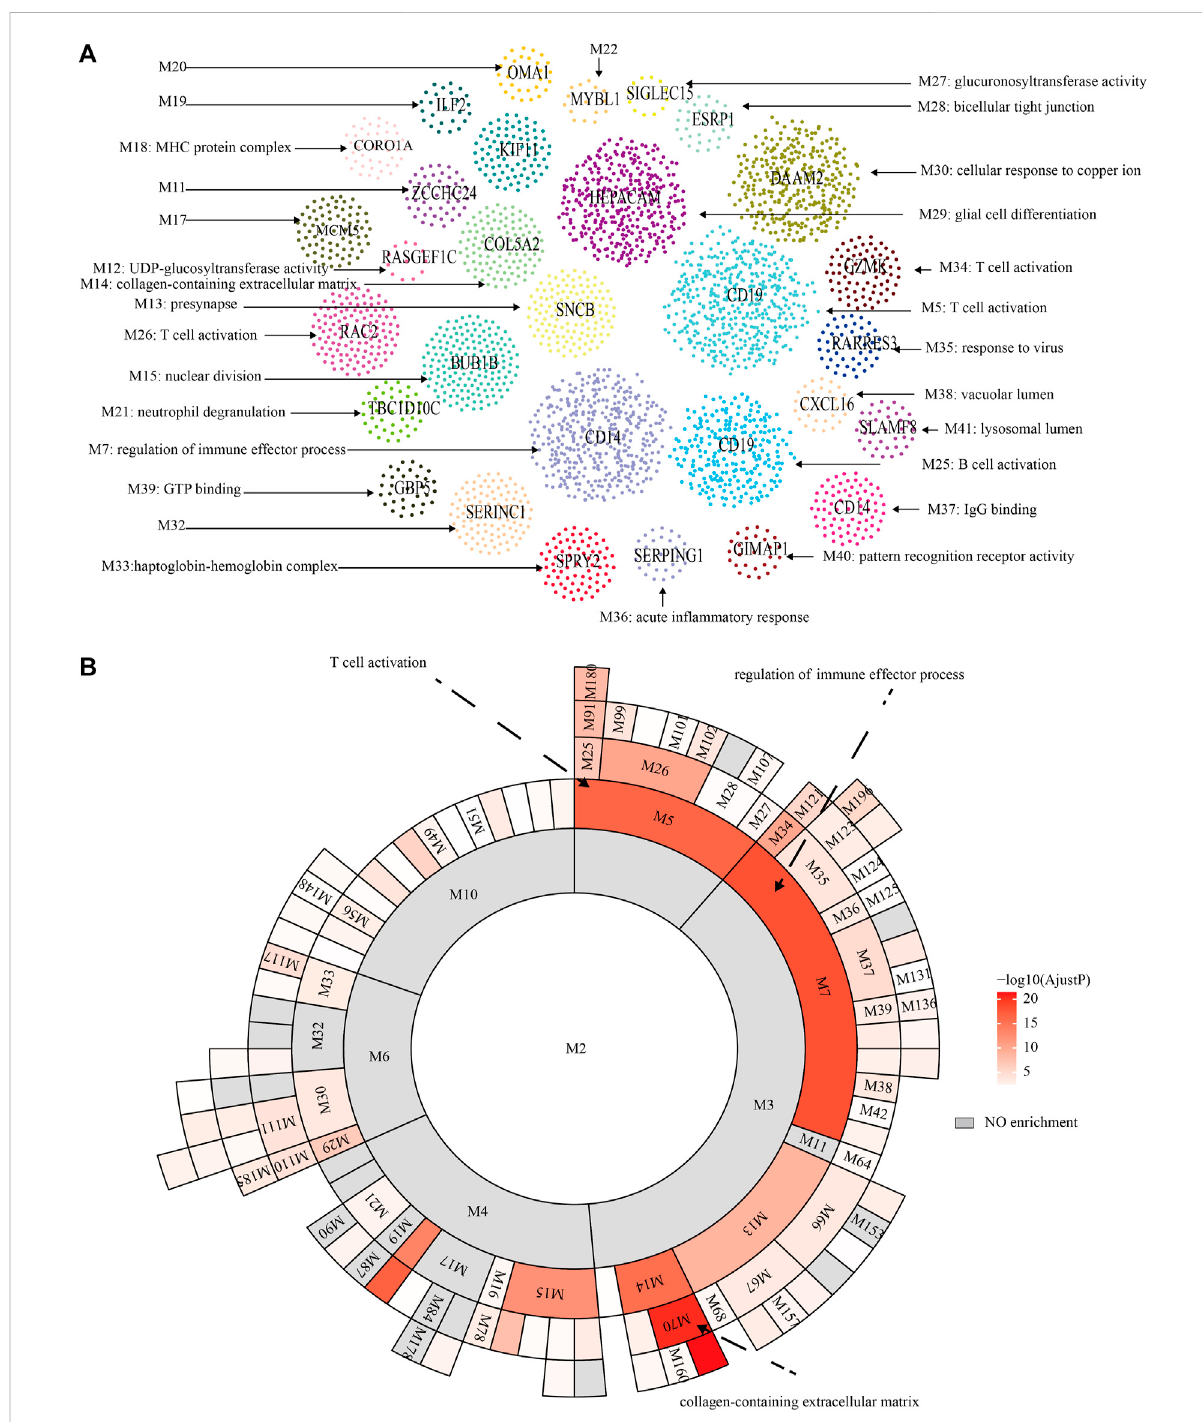
showing parent-child relationships (Supplementary Tables S2, S3). The topmost modules in the network are assigned at a particular compactness scale (Figure 2A). The